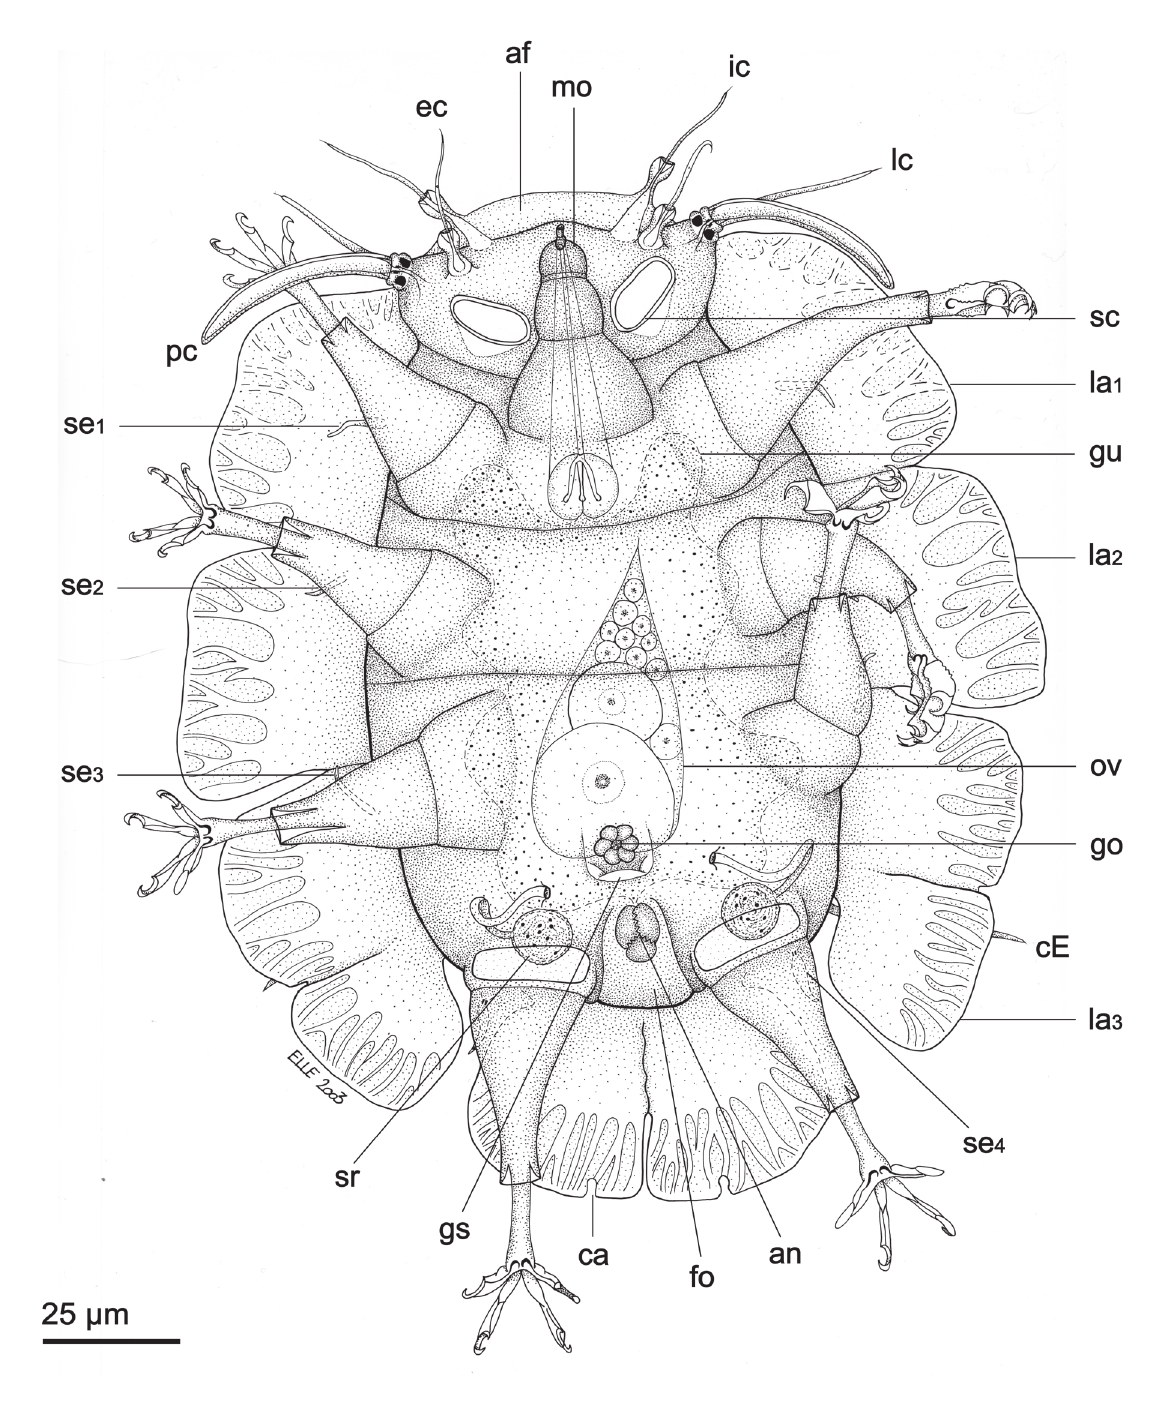
Fig. 2. Higginsarctus signeae gen. et sp. nov. Ventral overview. Holotype, ♀ (NHMD-293899). Abbreviations: see Material and methods. Drawing by Stine B.